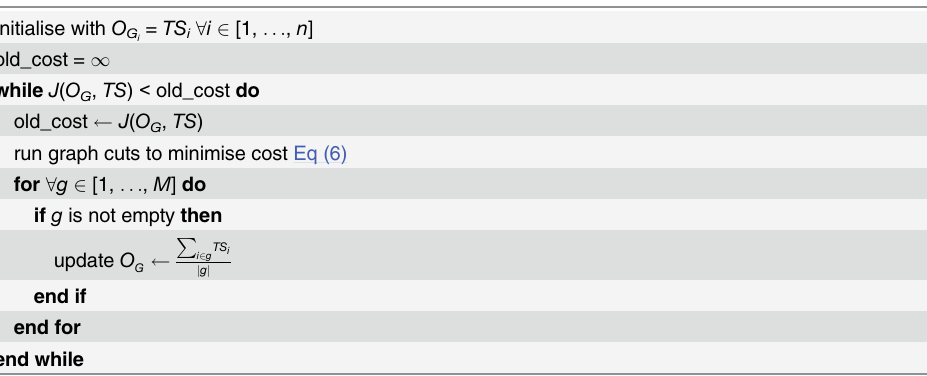
Table 2. Algorithm 1 Finding shared focal